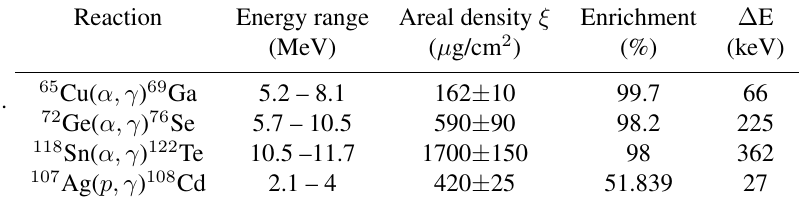
Table 1. Nuclear reactions, energy ranges and relevant target properties (see text in sect. 2 for details)